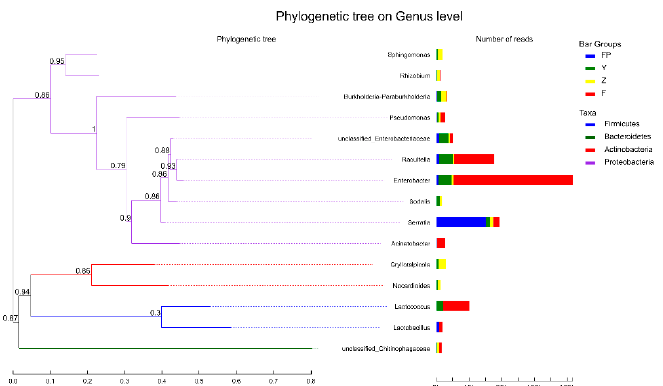
Figure 7. Phylogenetic trees based on maximum likelihood of 16S rRNA gene sequences of the top 15 genera in intestine samples of M. alternatus and tissue samples of P. massoniana . Phylogenetic trees of the top 15 genera of larval guts, pupal guts, pupal chamber tissues, and larval gallery tissues. The number of reads is represented by the length of the bar. The colors of the lines are representative of different phyla.